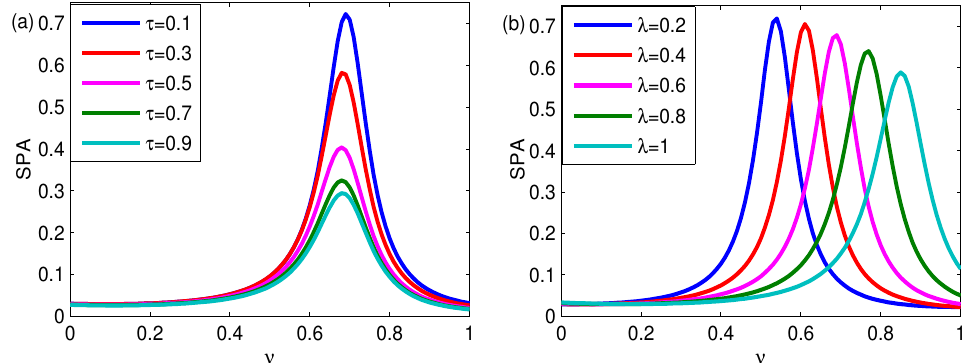
Figure 9. GSR behaviors of SPA( ν ) in (35) for distinct ( a ) τ and ( b ) λ . ( a ) α = 1.2, β = 0.2, ¯ γ = 0.1, δ = 1.6, µ = 0.8, a 2 = 0.6, λ = 0.6, q = 0.3, ω 0 = 1, Ω = 2; ( b ) α = 1.2, β = 0.2, ¯ γ = 0.1, δ = 1.6, µ = 0.8, τ = 0.2, a 2 = 0.6, q = 0.3, ω 0 = 1, Ω =